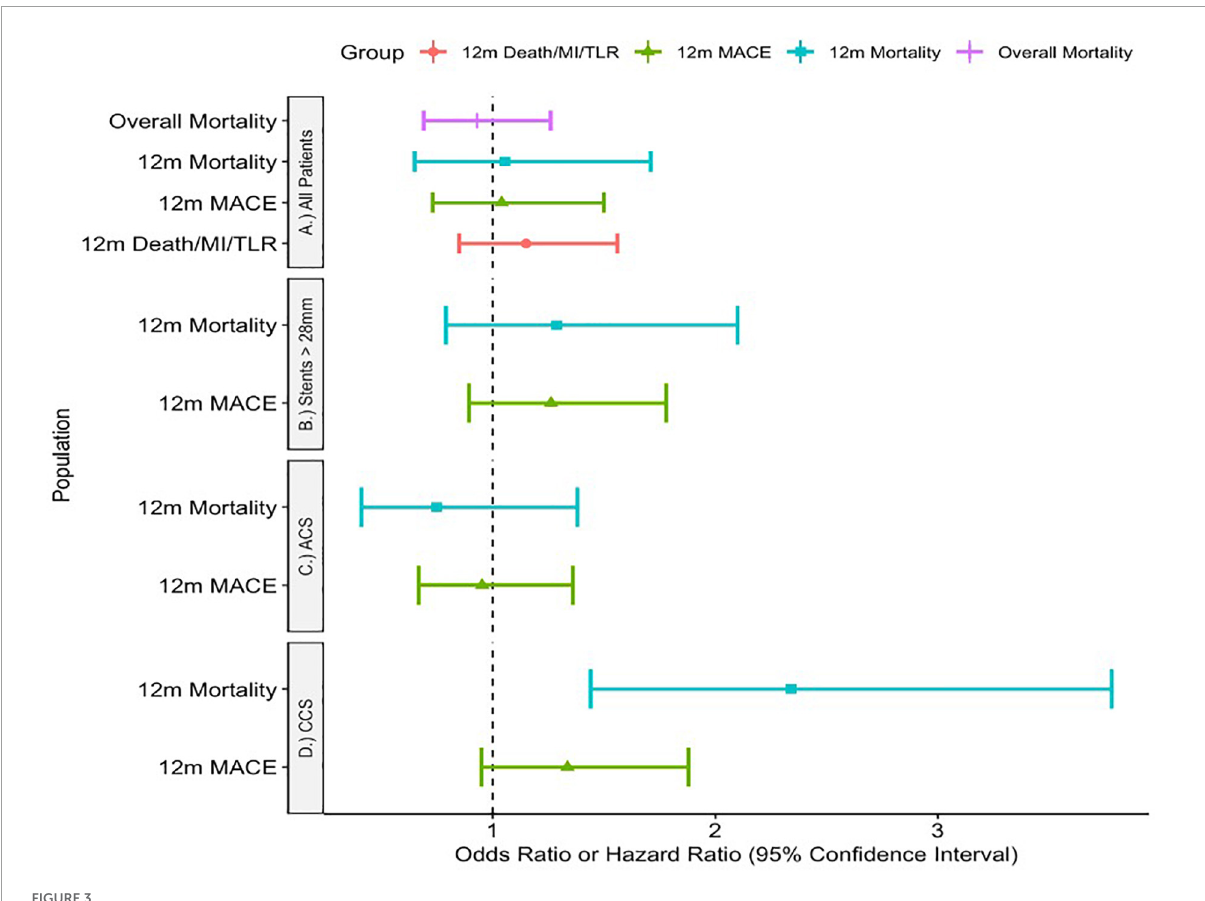
FIGURE3 Adjusted outcome